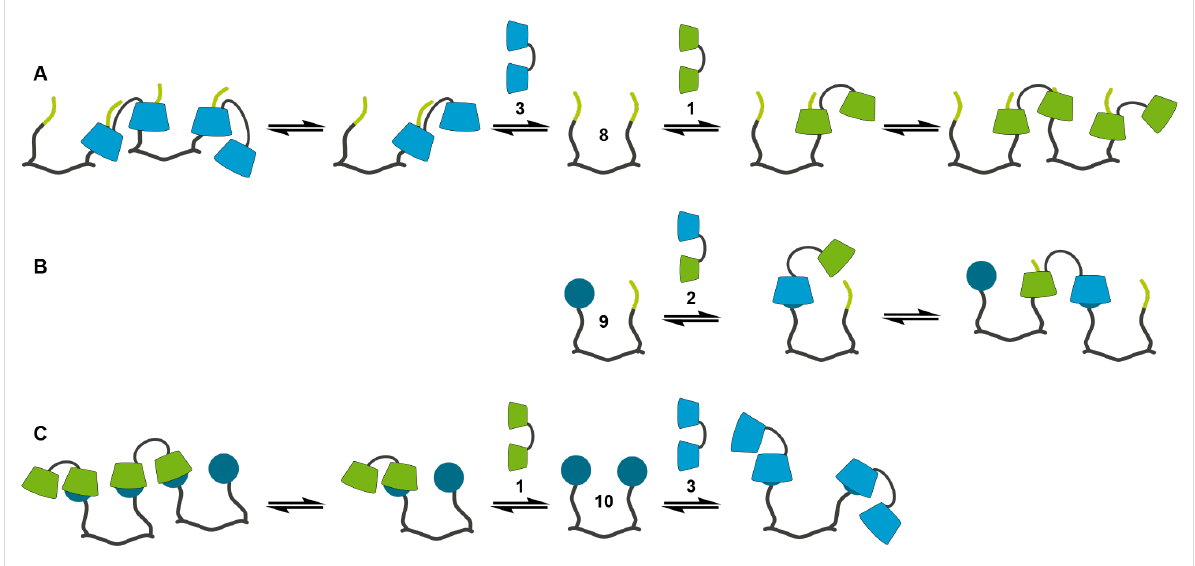
Figure 8: Schematic drawing of the interactions of the divalent guest molecules 8 (A), 9 (B) and 10 (C) with complementary (right) and non-comple- mentary (left) divalent CD strands.